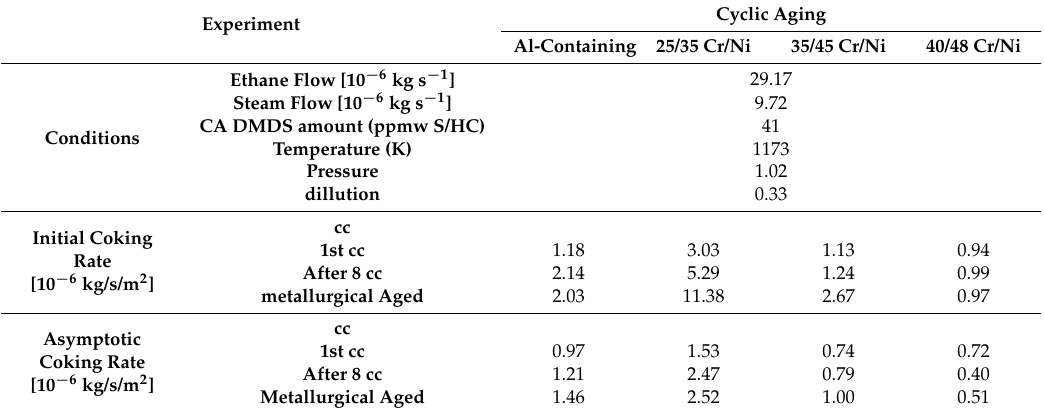
Table 3. Summary of the main coking